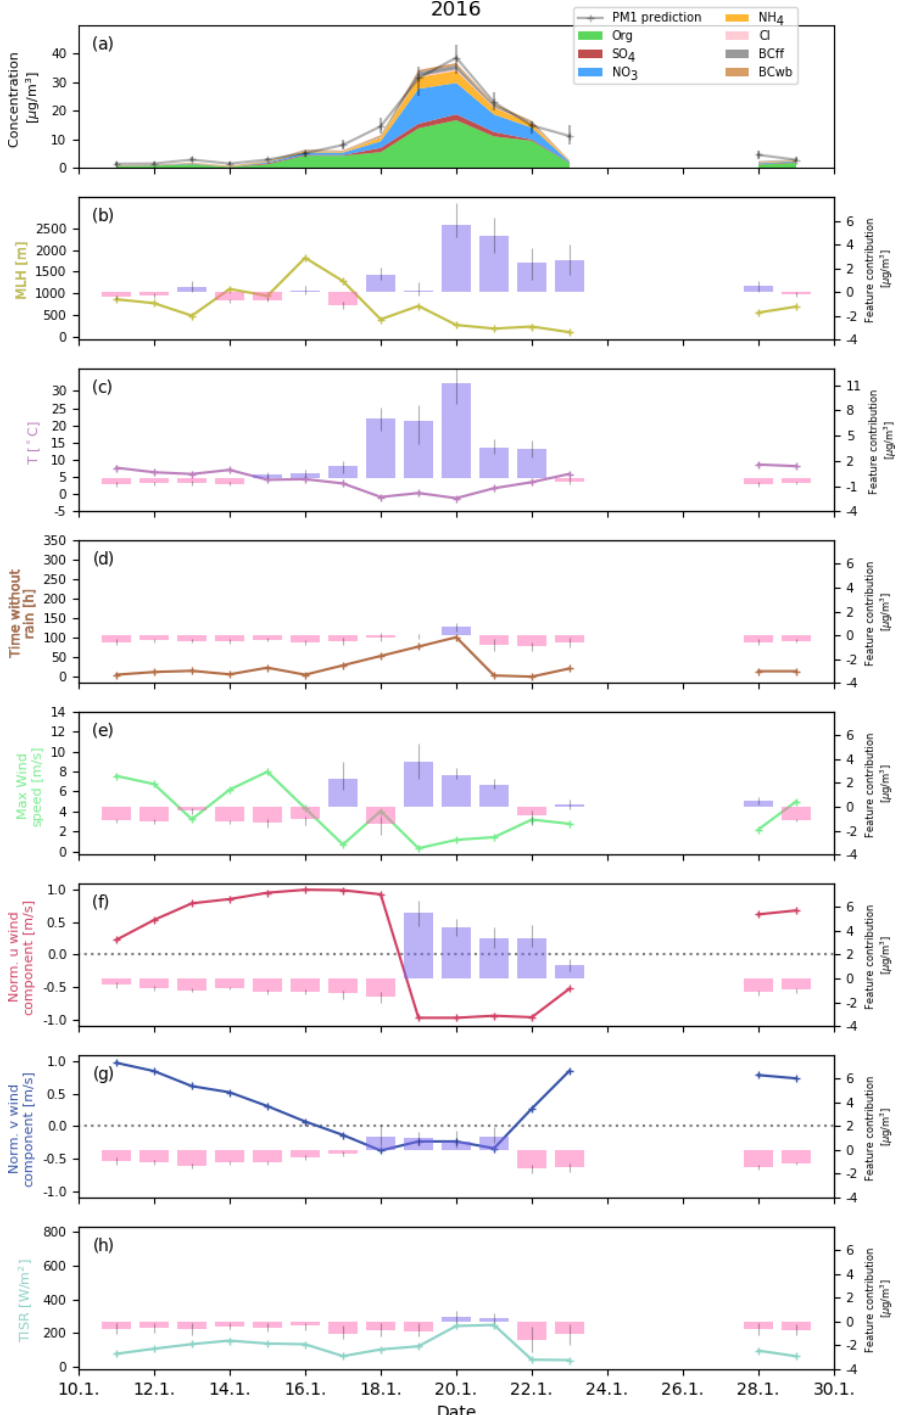
Figure 11. Winter pollution episode in January 2016. Panel (a) indicates the total PM 1 prediction as a horizontal black line with vertical black lines denoting the range of predictions of all 10 models. The observed species concentrations are shown as stacked planes in the corresponding colours. The subsequent panels show absolute values (left y axis, solid lines) and SHAP values (right y axis, pink bars for positive and blue bars for negative values) for the most relevant meteorological input features: MLH (b) , temperature (c) , hours after rain (d) , maximum wind speed (e) , normalized u wind (f) , and normalized v wind (g) component.